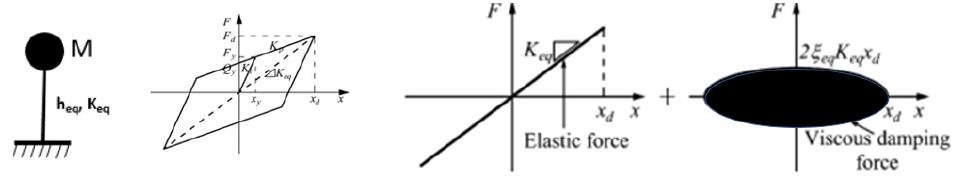
Figure 25. Equivalent linearization of SDOF SI structure .